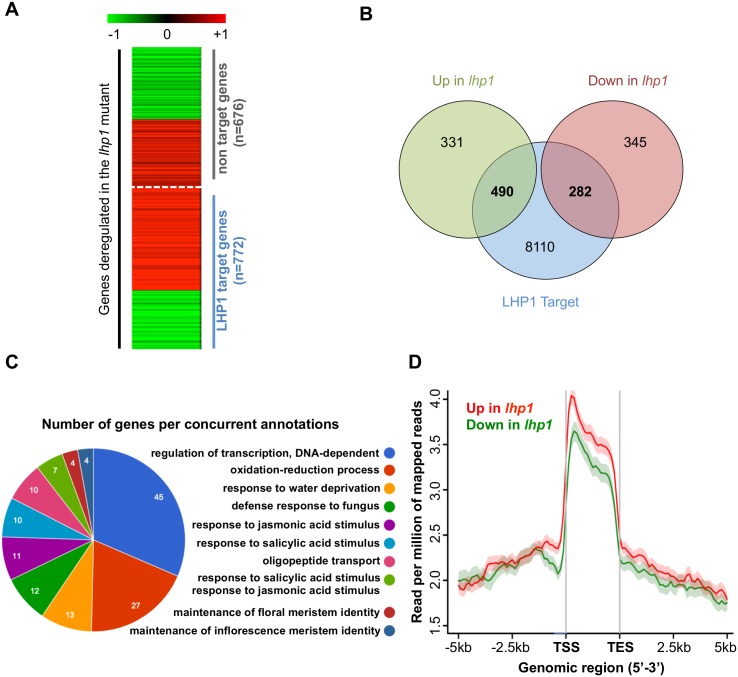
Relationship between the level of LHP1 binding and the magnitude of gene expression.(A) Heatmap showing fold change of expression level of LHP1-targeted and LHP1 unmarked genes in the lhp1 mutant compared to WT (Genes with a log2 fold change of -1 or lower are coloured in green and genes with a log2 fold change of +1 or above are coloured in red). Only genes which are mis-regulated in lhp1 are shown here. LHP1-targeted genes are predominantly up-regulated in the mutant lhp1. (B) Venn diagram showing the relationship of LHP1-targeted genes to gene expression. A higher number of LHP1-targeted genes are up-regulated in the mutant lhp1, compared to non-target genes. (C) Functional annotation of LHP1 targets which are up-regulated in the lhp1mutant (UT). (D) Average tag density profile of LHP1 on targeted and differentially regulated genes. Mean-normalized ChIP-Seq densities of equal bins along the gene and 2-kb region flanking the TSS or the TES were plotted. Up and down regulated genes are categorized with a p-value cutoff of 0.05 and fold change of one.